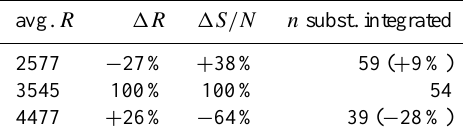
Table 2. Comparison of different resolving power settings with regard to changes in sensitivity. Values based on 10 measurements per setting and 37 calibration masses for resolution calculation (avg. R, (cid:49)R) . Changes in S/N ( (cid:49)S/N) determined as the mean relative change in S/N for 39 substances. From the total of 68 identified substances, a variable fraction could be integrated depending on the resolving power setting as shown in the last column ( n subst. integrated). All values were determined with accurate mass intensities.